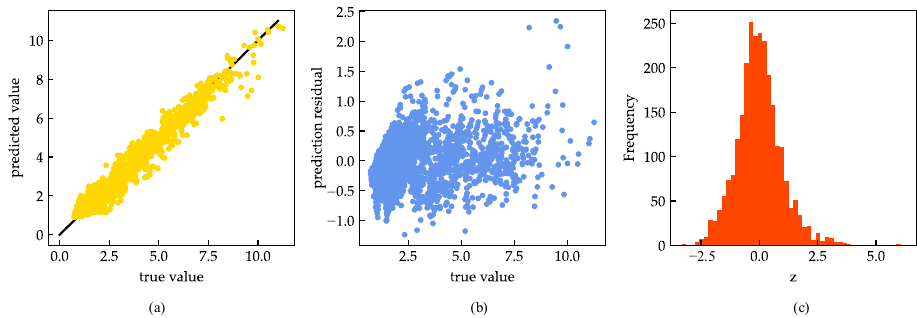
Figure 12. The prediction performance of improved stacking: ( a ) The scatter plot between predicted